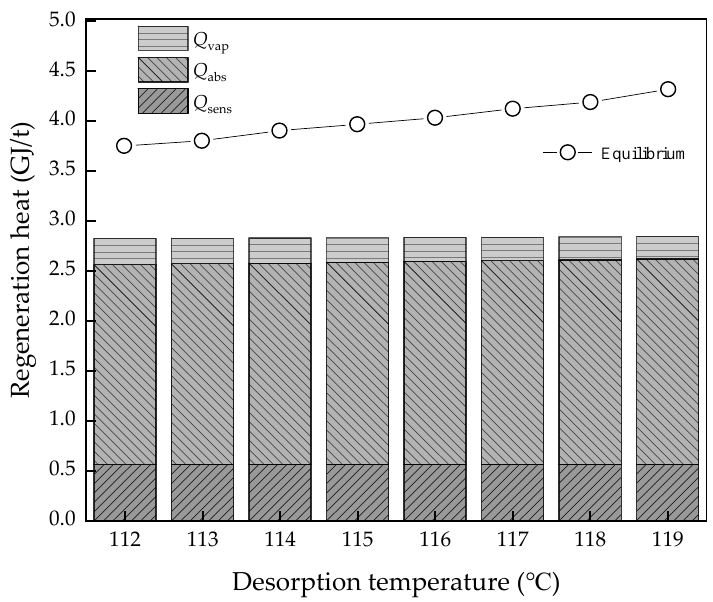
Figure 10. The regeneration heat changes with the desorption temperature variation.